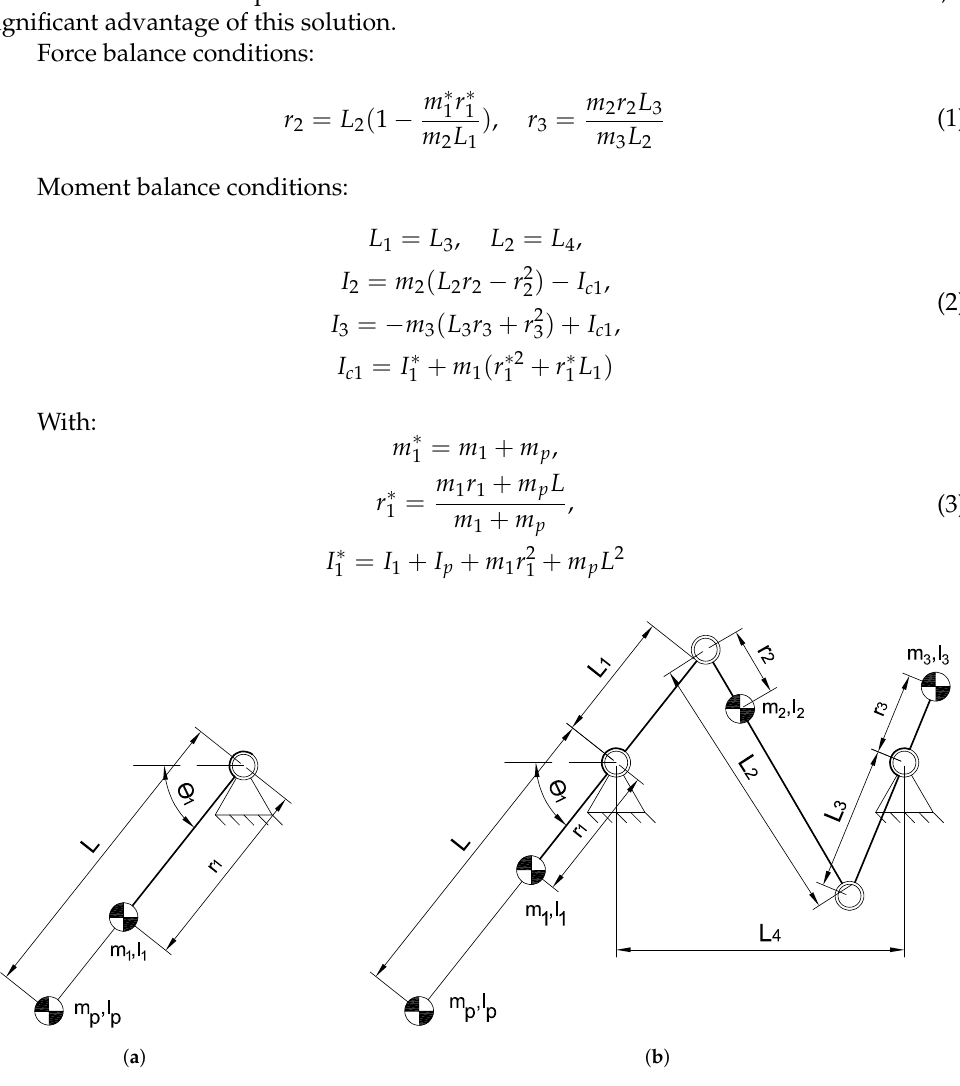
Figure 1. ( a ) Unbalanced rotatable link; ( b ) Rotatable link as manipulator arm within a dynamically balanced inverted four-bar linkage (adapted from